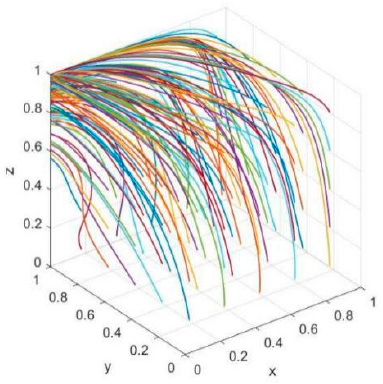
Figure 5. Evolution simulation development at the initial stage point (1, 1, 1).